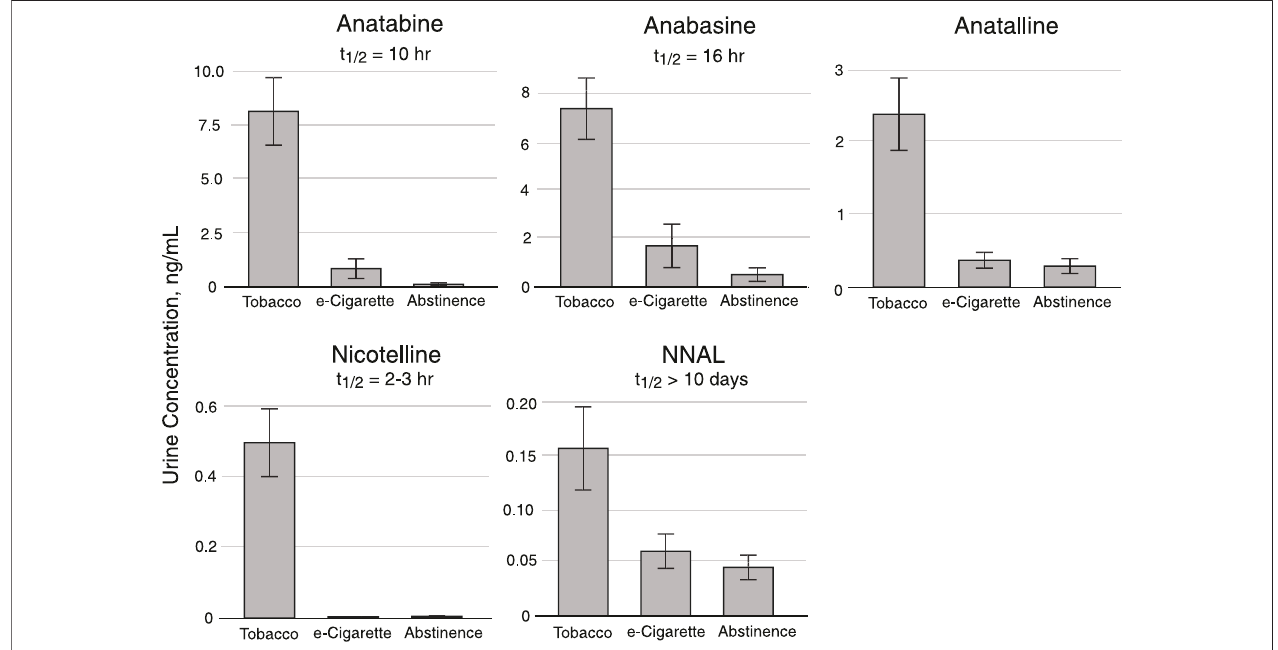
FIGURE 8 | Urine concentrations of Anatabine, anabasine, anatalline, nicotelline, and NNAL in dual users of combusted cigarettes and e-cigarettes enrolled in a crossover study carried out on a research ward. Participants were inpatients in three 2-day study blocks. For this subset of participants ( n = 19), the 2-day abstinence block immediately followed the e-cigarette block. For the fi ve days prior to the e-cigarette block, participants were instructed to use their usual e-cigarette product ad libitum and not use other tobacco or nicotine-containing products. However, since they were outpatients, compliance could not be enforced. Urine (24 h pool) collected during the second day of each 2-day study block was analyzed for the biomarkers. The “ Tobacco ” columns data were obtained during the 2-day cigarette smoking block. Individual sample data are in the Supplementary Material document.